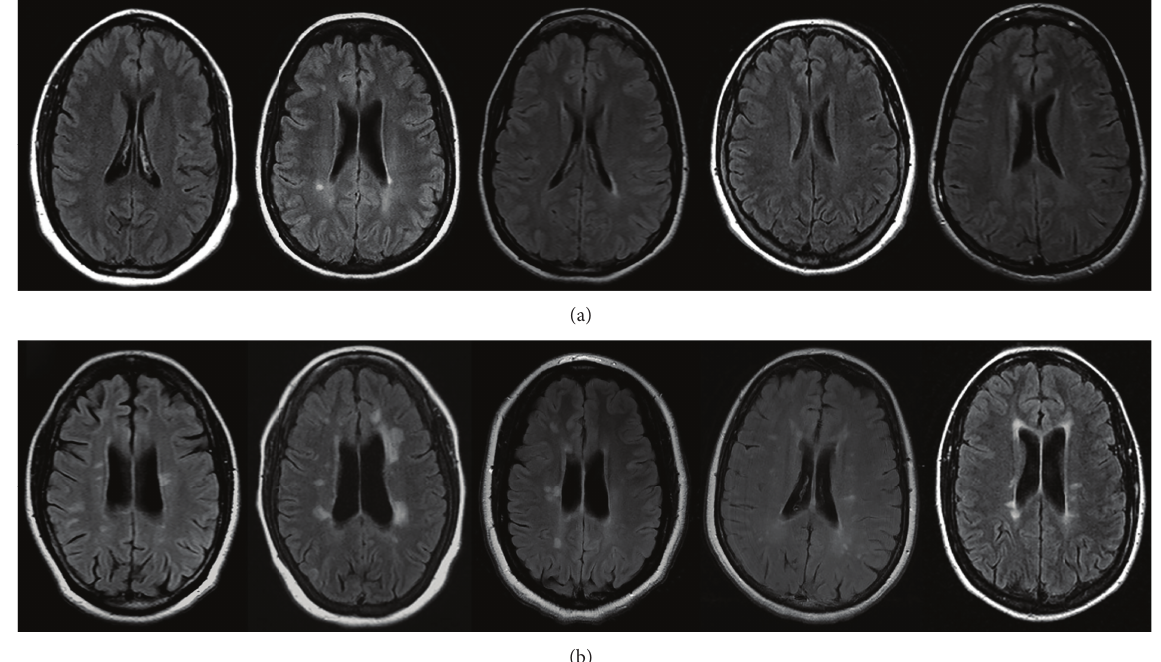
Figure 2: Patterns of the periventricular lesions on axial FLAIR images. Five representative patients with NMO are shown in (a): periventricular white matter is either devoid of lesions or contains smooth periventricular linear hyperintensity (with the exception of single patient). In contrast, five representative MS patients (b) demonstrate periventricular lesional patterns B, more compatible with focal perivenous